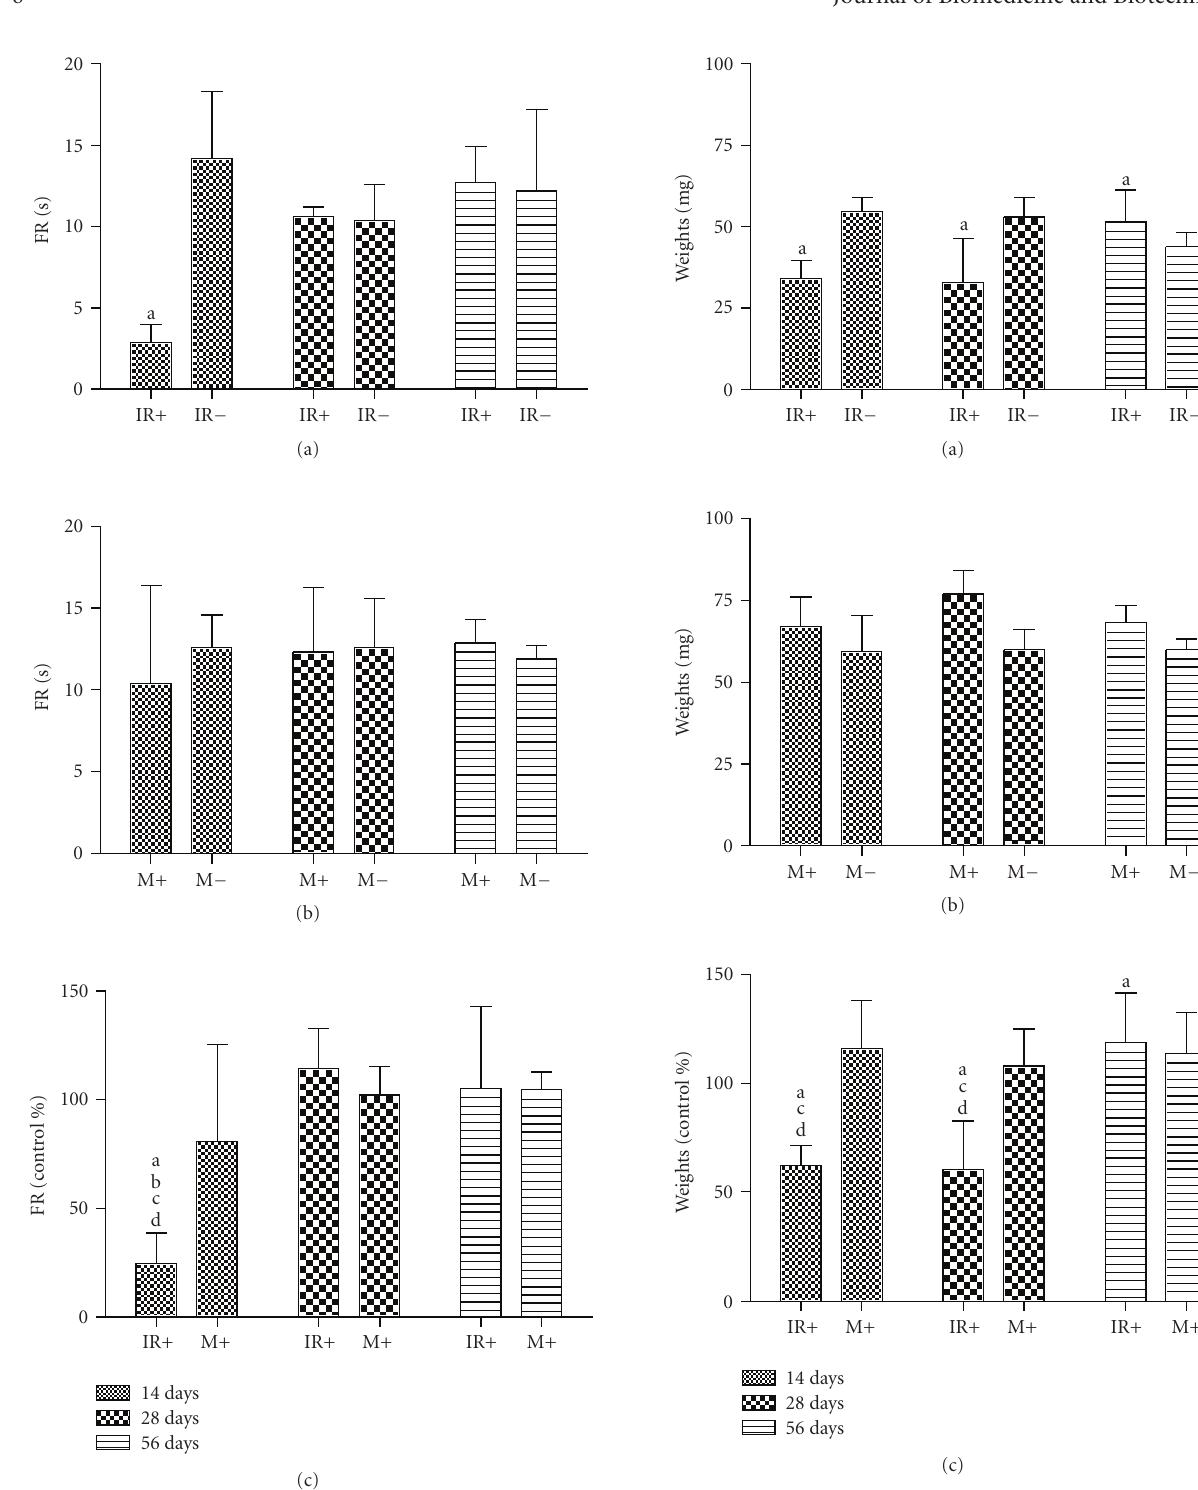
Figure 5: Muscle weights after ischemia-reperfusion injury and myotoxic injury. Values are means ± SEM. Number of data per group is 4–6. IR+: ischaemic/reperfused muscles, IR − : control muscles of ischaemic/reperfused muscles, M+: myotoxin-treated muscles, M − : control muscles of myotoxin-treated muscles-do not you-mean contralateral muscle of myotoxin-treated mice?. (a) significantly di ff erent from control ( P < . 05), (b) significantly di ff erent from 28 days ( P < . 05), (c) significantly di ff erent from 56 days ( P < . 05), (d) significantly di ff erent from